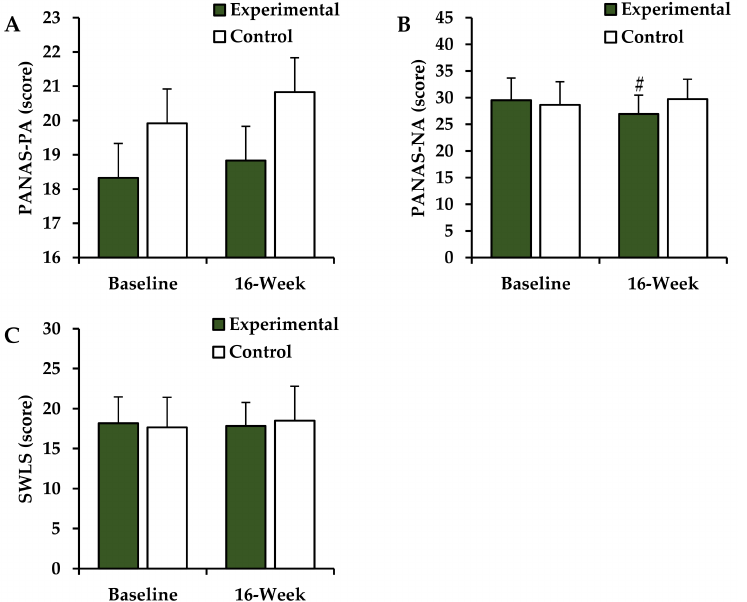
( F = 1.321, p = 0.321) scores in either group.